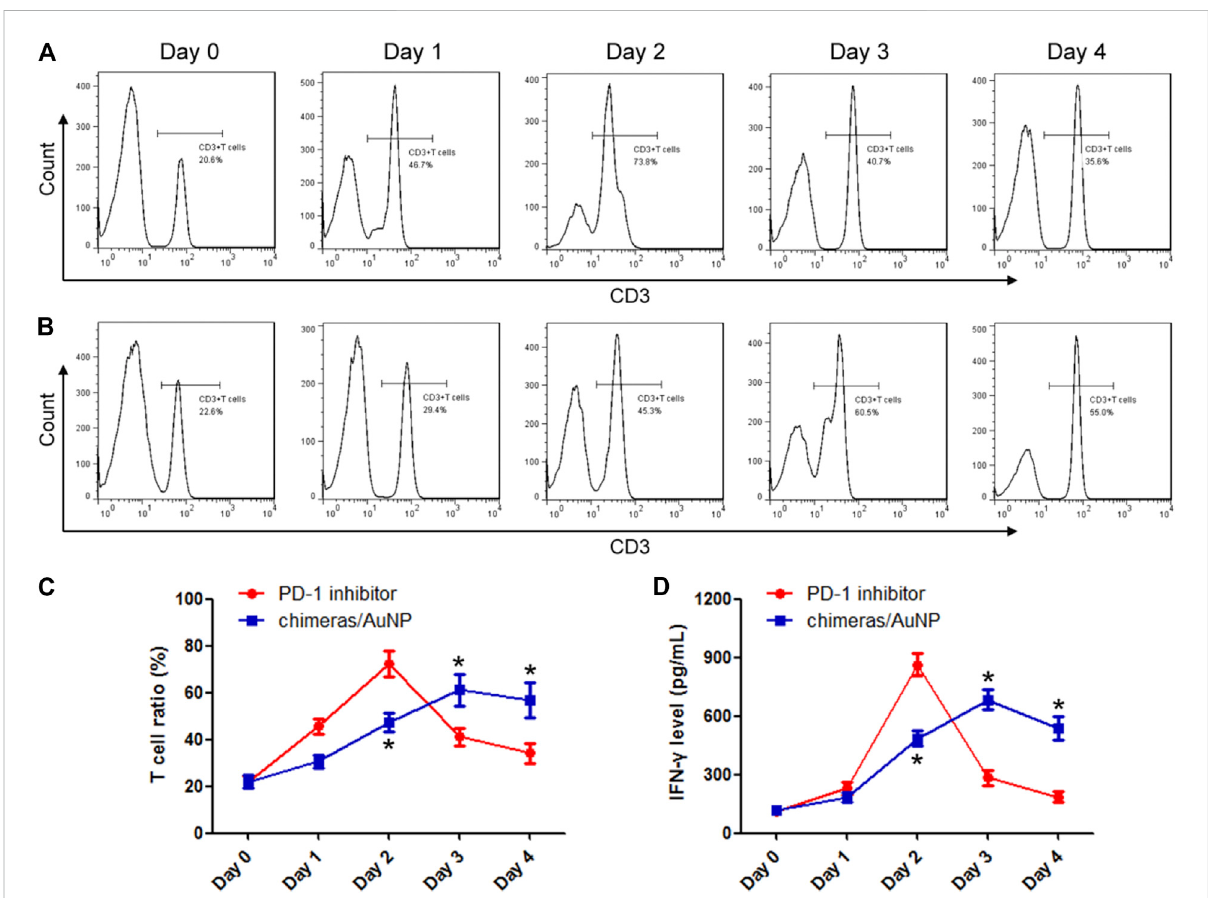
FIGURE 2 Chimeras/PEI/PEG/AuNPsprogressively activated Tcells inmalignantpleural effusion. Malignant pleural effusionsfrom patients with advanced lung adenocarcinoma were collected and treated with PD-1 inhibitor (A) or chimeras/PEI/PEG/AuNPs (B) , respectively (C,D) PD-1 inhibitor could rapidly activate T cells, T cell proportion and IFN- γ concentration increased rapidly, and reached the peak 48 h later. Then T cell proportion and the concentration of IFN- γ released began to decrease. Chimeras/PEI/PEG/AuNPs slowly activated T cells, and T cell proportion and IFN- γ concentrationincreasedgradually.* p < 0.05(n=10)versusPD-1inhibitor.Valuesaremean±SD.Chimeras/PEI/PEG/AuNPscontinuouslykilledlung adenocarcinoma